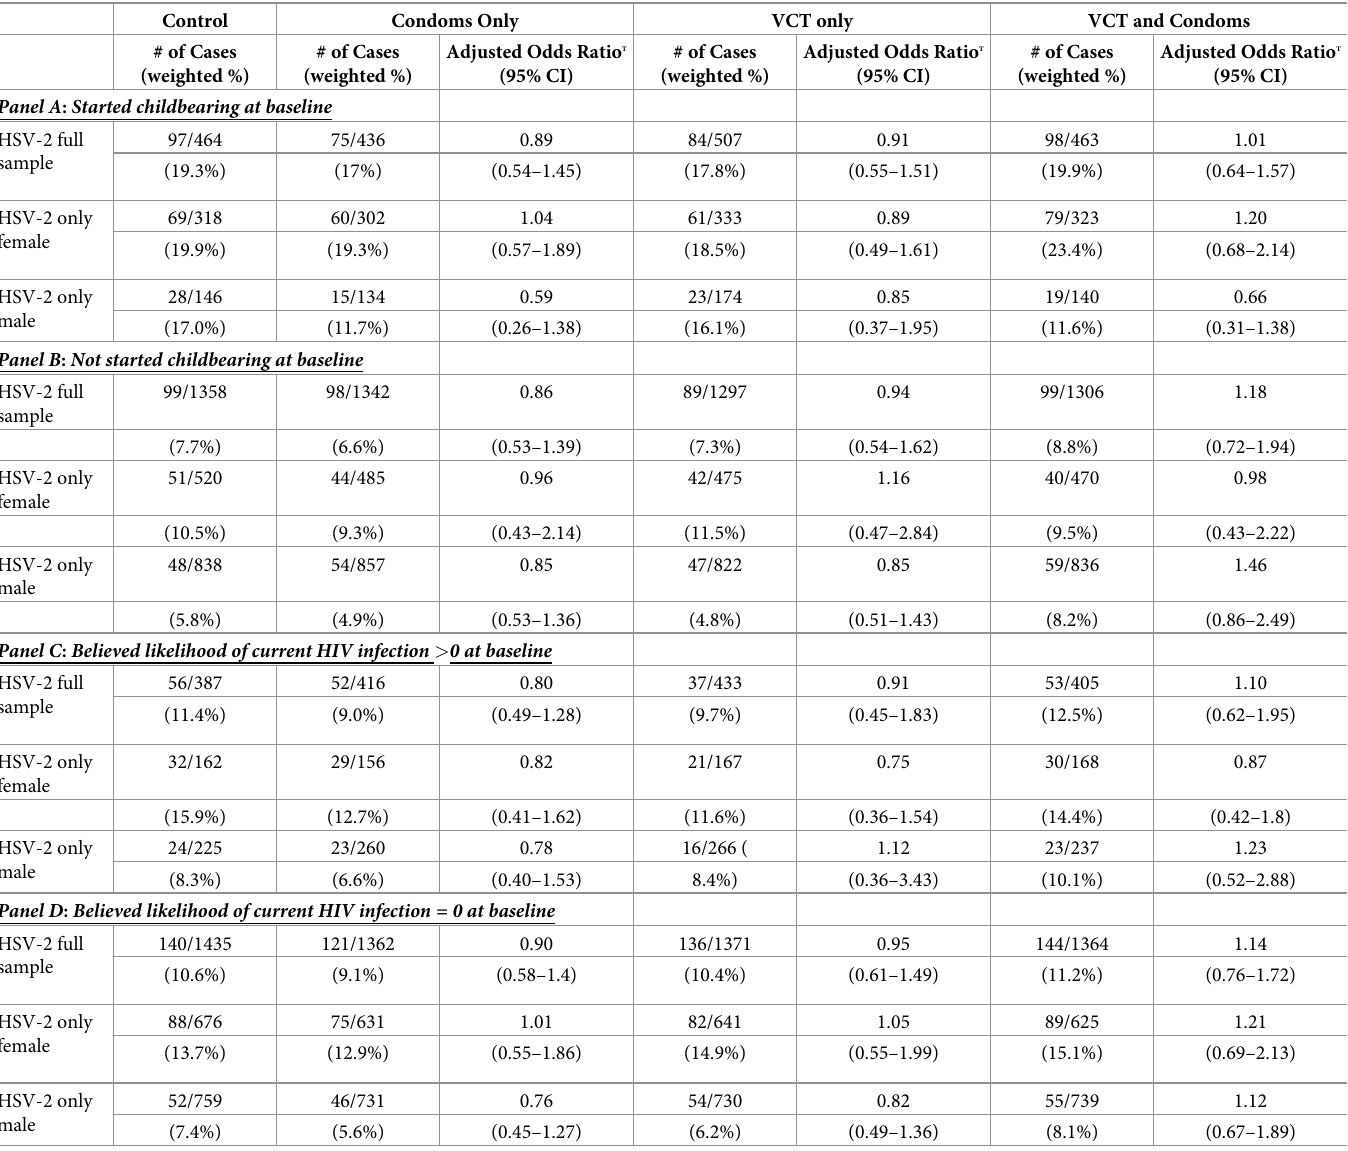
Table 4. Impact on HSV-2 by childbearing status and beliefs on